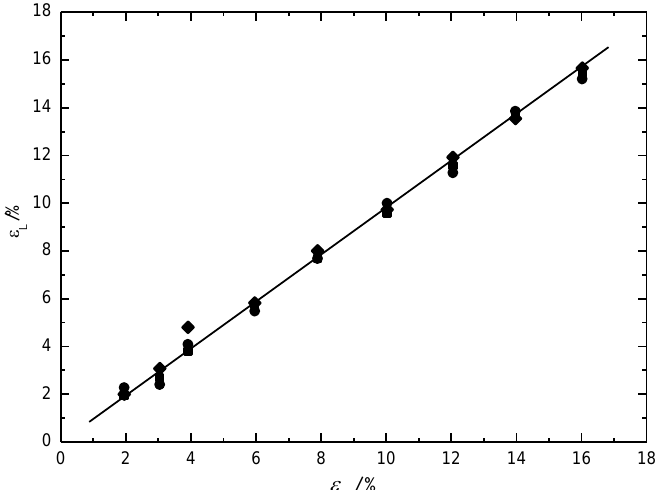
Figure 5. Relationship between axial accumulative strain and axial total strain.